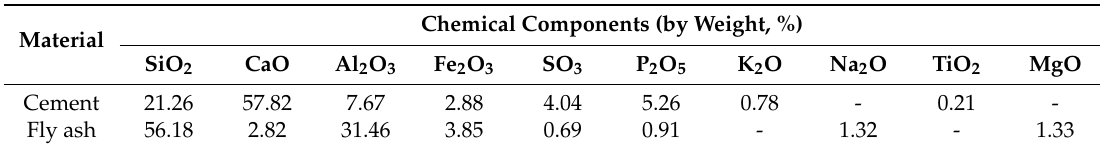
Table 1. Chemical composition of Portland cement and fly ash.